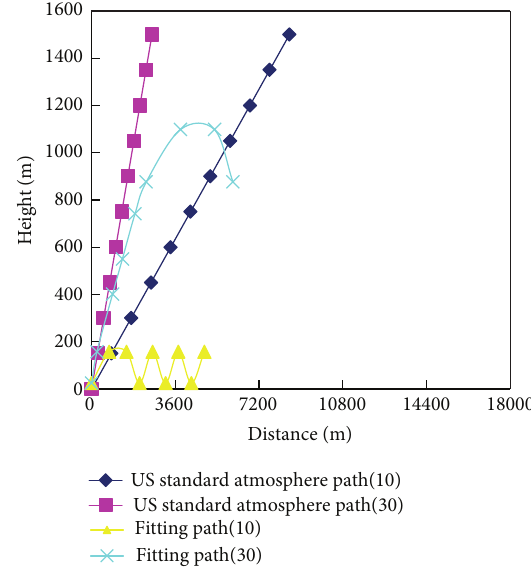
Figure 4: The propagation path of the radar beam in a super- refractive atmosphere during the airplane’s